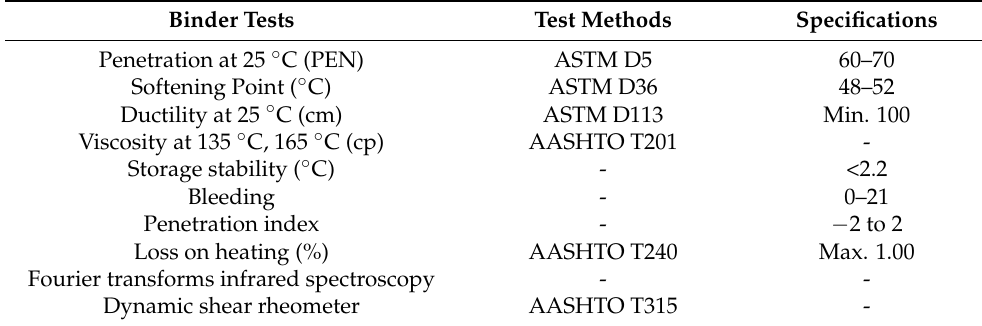
Table 1. Physical, rheological, and chemical properties tests of the bituminous binder.